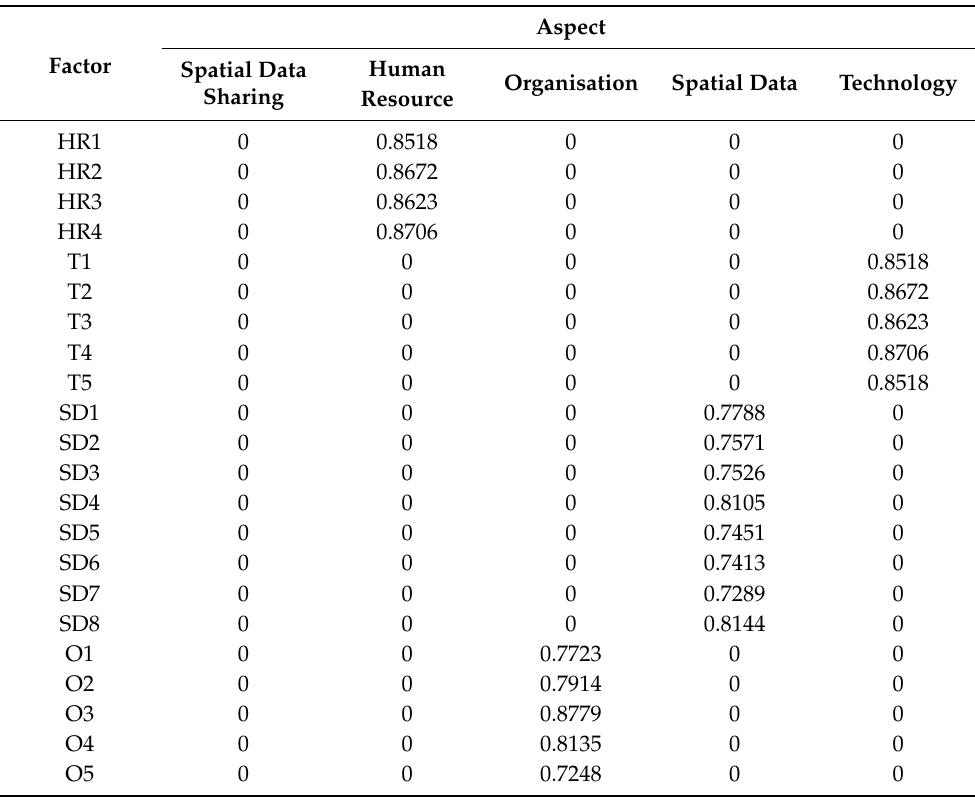
Table 6. Factor loading value of each factor to its latent variable in this study.